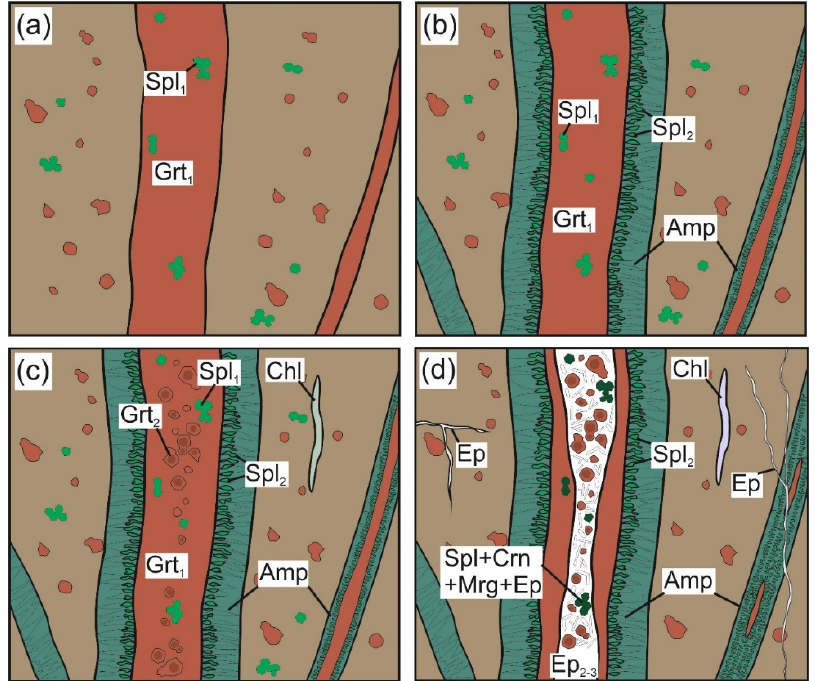
Figure 5. Evolution sketch of the vein system in ultrabasic amphibolites of Mt. Nieddu. ( a ) First stage, garnet vein formation; ( b ), ( c ) Second stage, amphibole formation and growth of compositionally zoned garnet crystals; ( d ) Third stage, epidote formation. Grt = garnet; Spl = Spinel; Amp = amphibole; Ep = epidote; Chl = chlorite; Mrg = margarite; Crn = corundum.